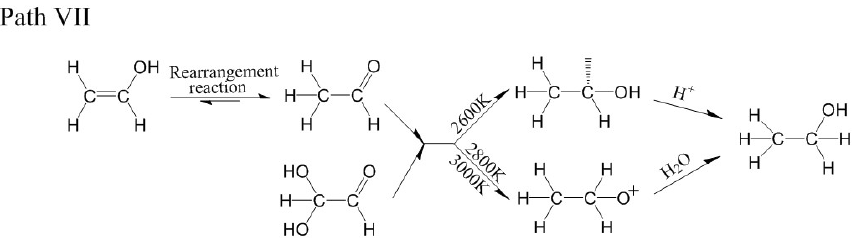
Figure 24. Relevant path VII of ethanol generation. By analyzing the pyrolysis path, the pyrolysis mechanism of cellobiose and its inter- mediate products were summarized and shown in Figure 25.